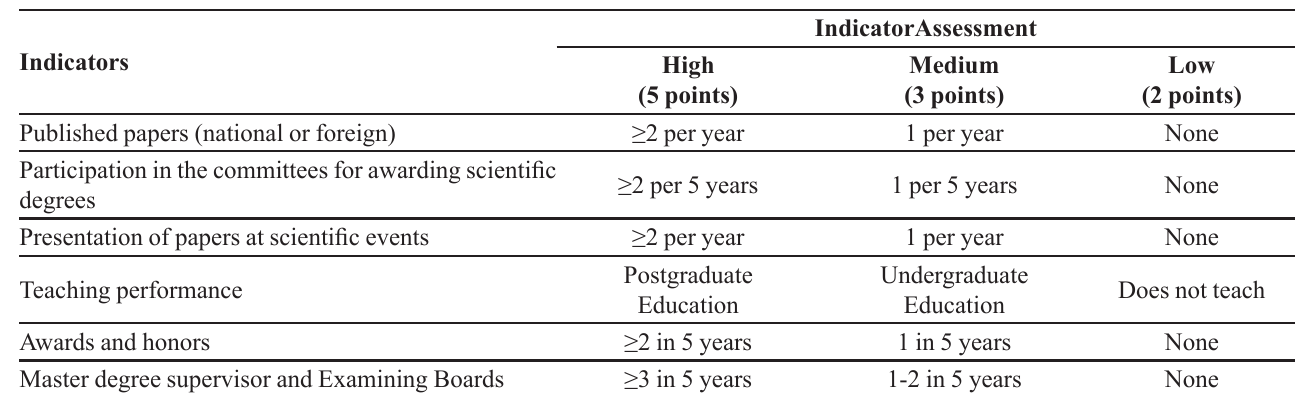
TABLE I - Indicators to assess the experts’ competence based on the curriculum vitae (last 5